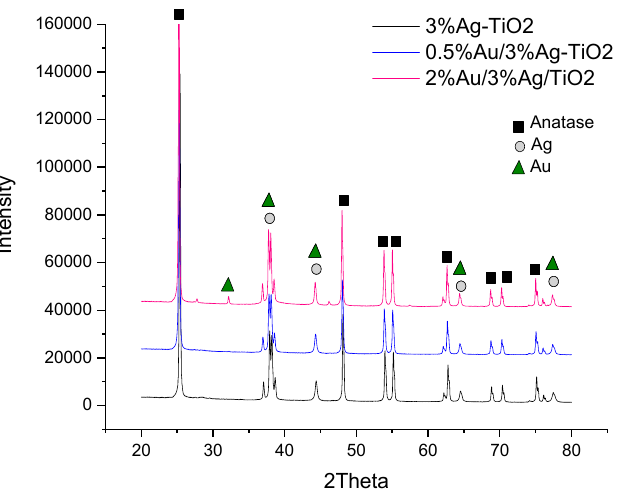
Figure 3. XRD patterns of the 3%Ag-TiO 2 (black line),0.5%Au/3%Ag-TiO 2 (blue line), and 2%Au/3%Ag-TiO 2 (pink line). The phase attributions of the main peaks are also reported. From the diffractograms reported in Figure 3, peaks related to TiO 2 anatase (JCPDS No.: 88–1175 and 84–1286) are clearly detectable in all samples. The phase composition of